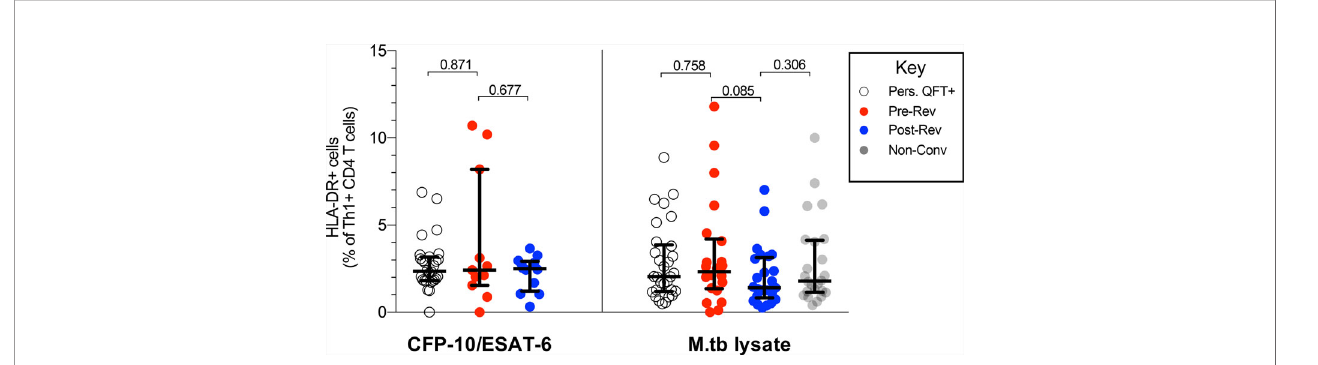
FIGURE 4 | QFT reversion is not associated with a decrease in T cell activation. Graphs depict proportions of HLA-DR+ CFP-10/ESAT-6- and M.tb lysate- speci fi c Th1 cytokine+ CD4 T cells in persistent QFT+, pre-and post-reverters and non-converters. Number of participants in each group, con fi rmatory statistical analysis and p-value calculations is as in Figure 2C